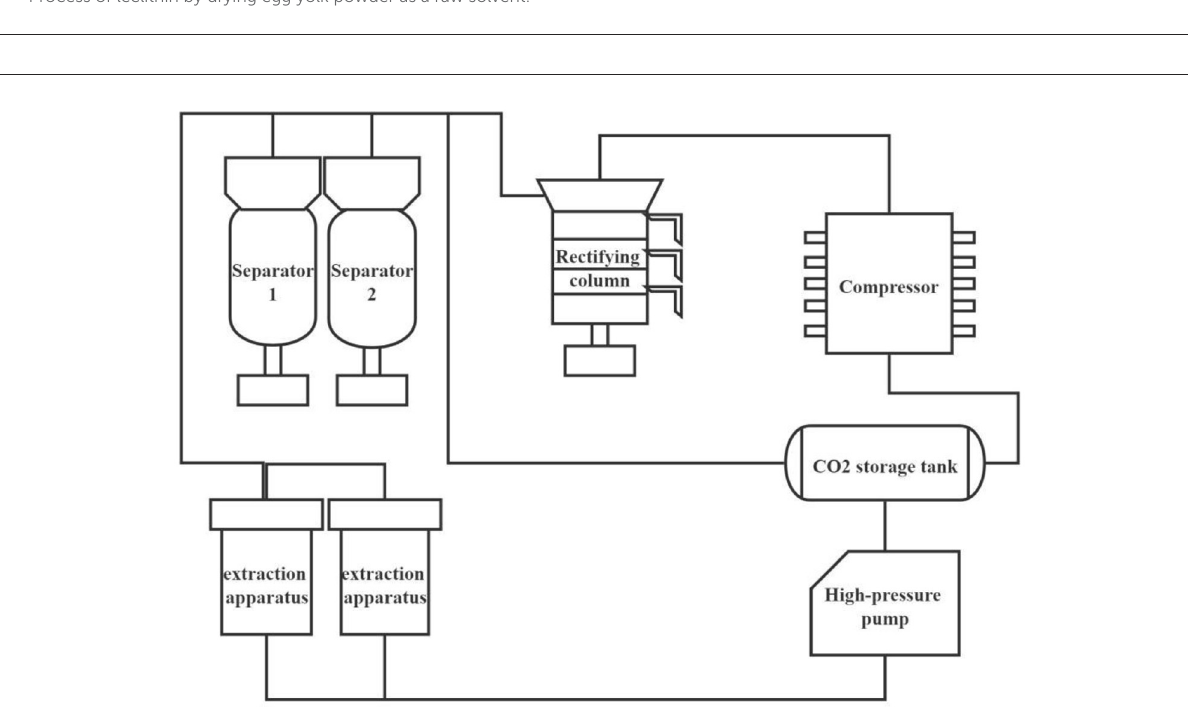
FIGURE2 Supercritical extraction